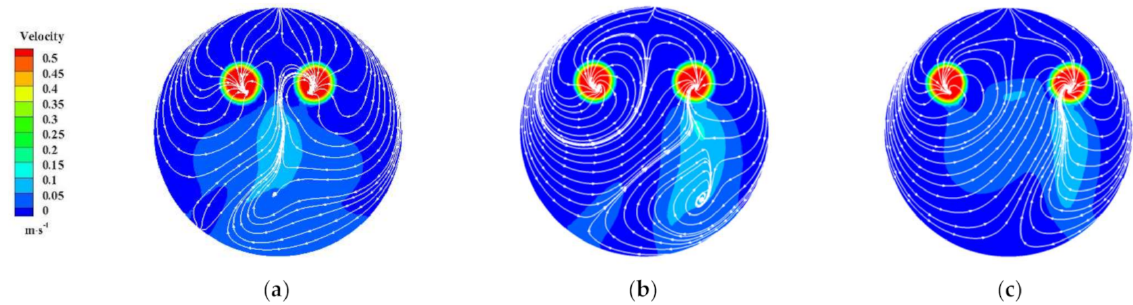
Figure 12. Streamline and velocity nephogram of Section 4-4 of the sump under different S values: ( a ) S = 0.6 R ; ( b ) S = 0.8 R ; ( c ) S = 1.0